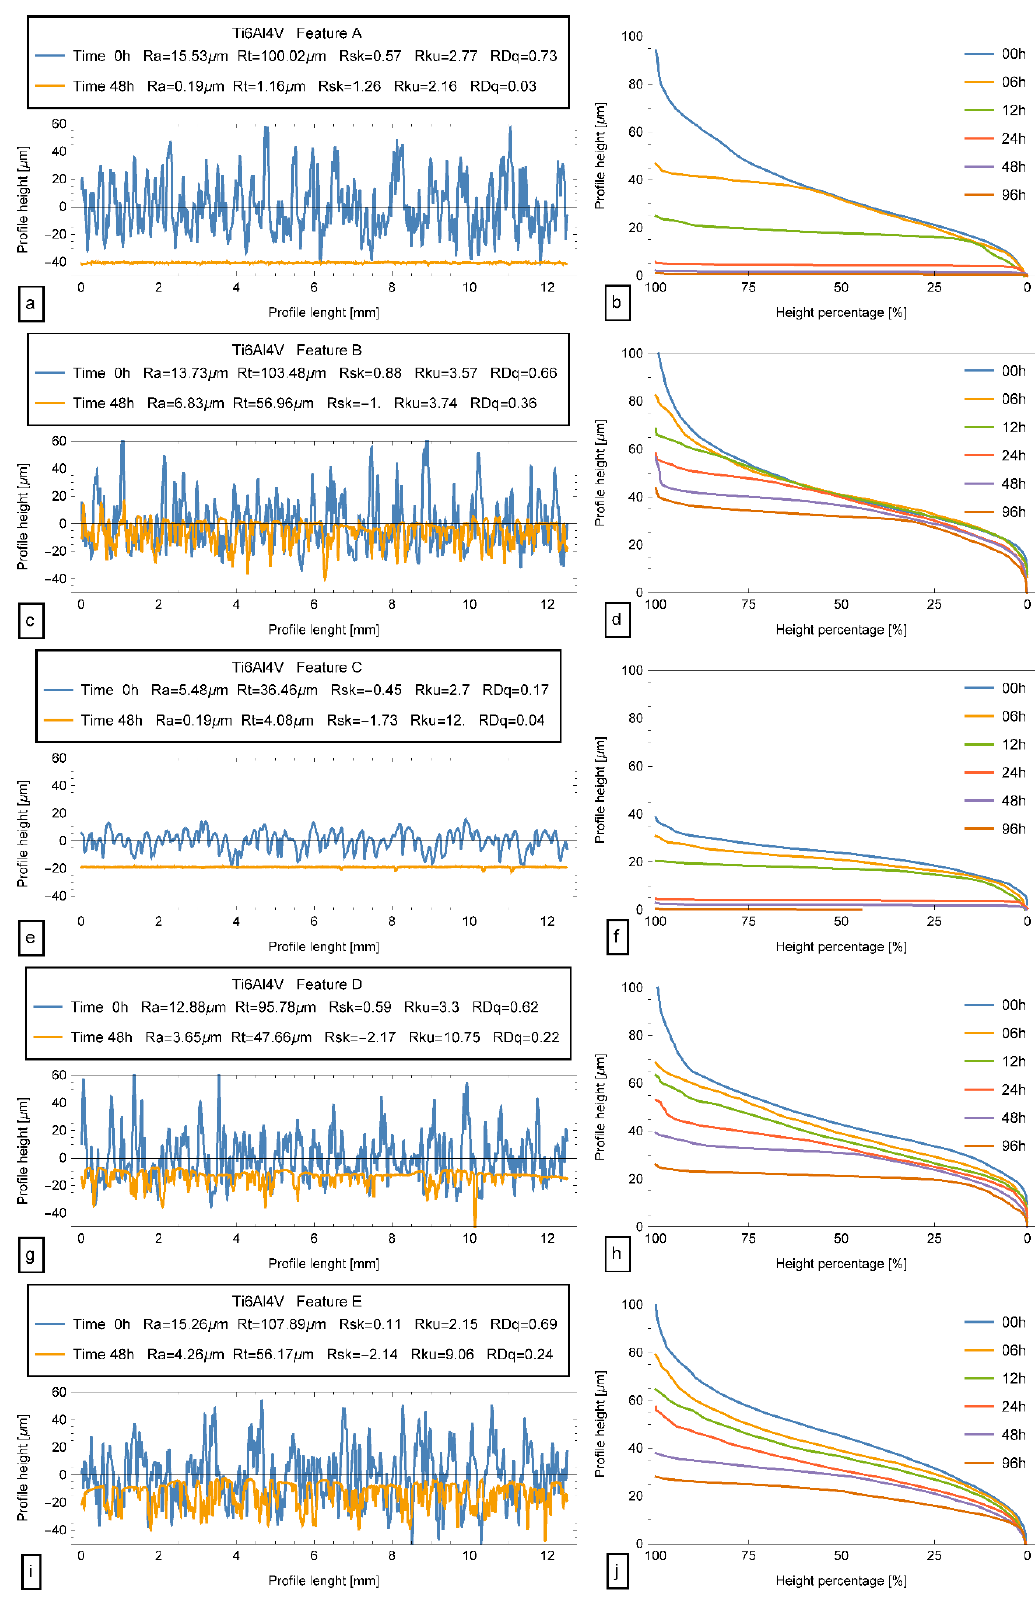
Figure 14. Roughness profiles before and after processing and aligned AFC curves at different BF working times for features: A (a,b), B (c, d), C (e, f), D (g, h) and E (i, j).